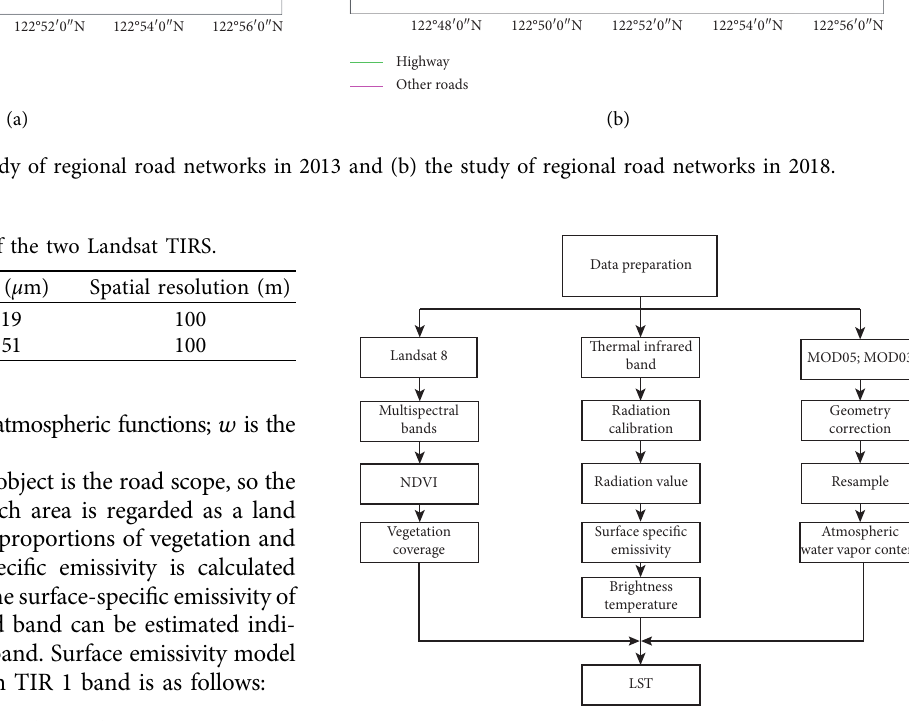
Figure 3: Flowchart of LST